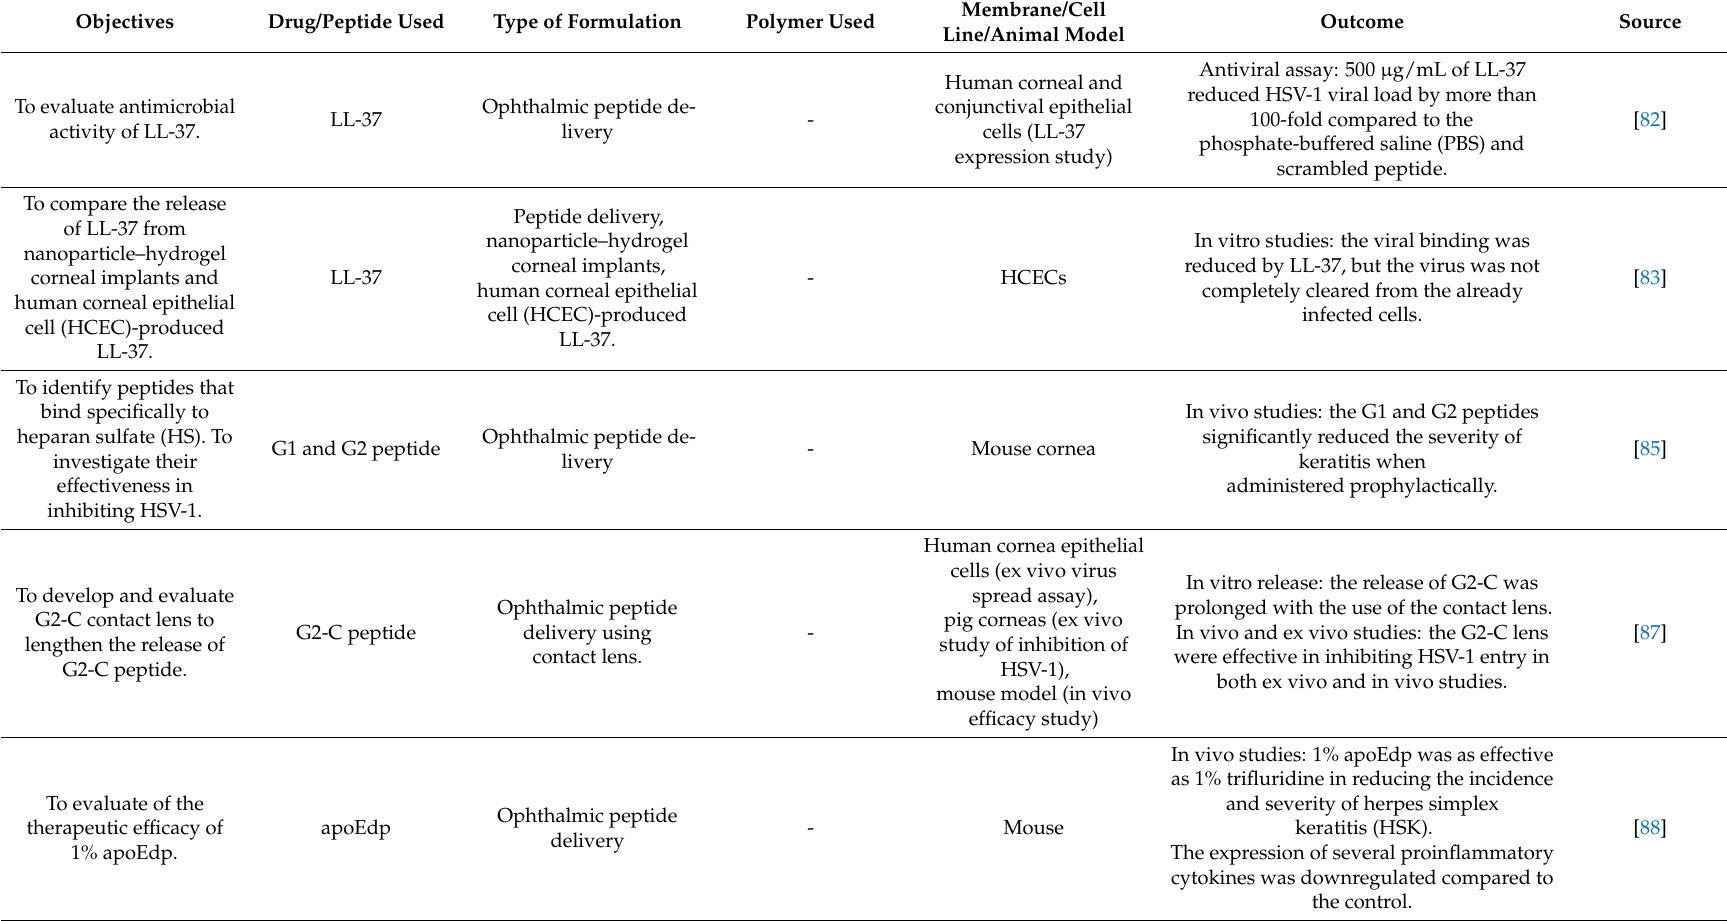
Table 4. Approaches to ocular delivery of peptides against herpes simplex virus